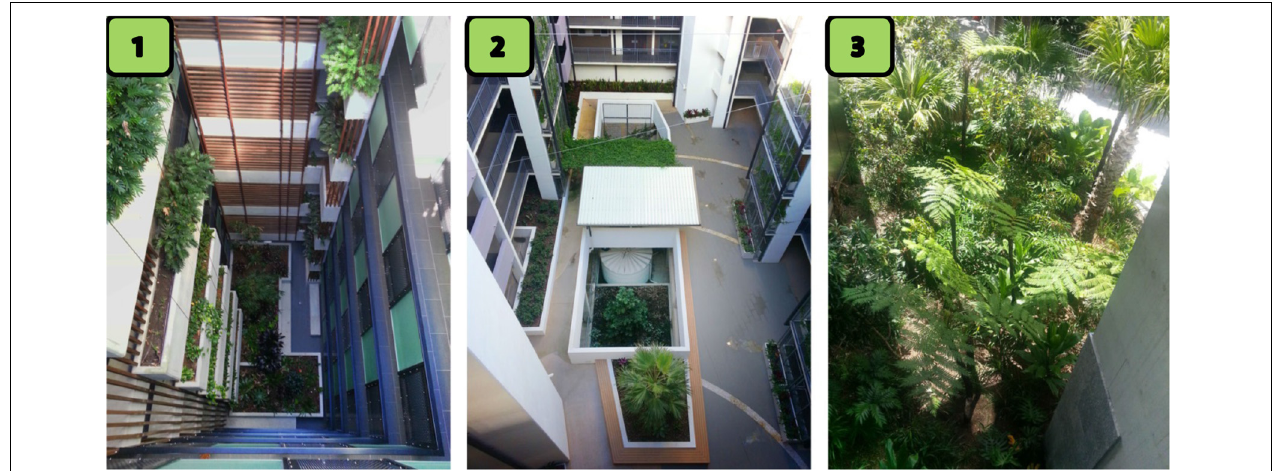
FIGURE 1 | Photographs of the three building sites, labeled as 1–3 used in this study to show that all plantings were outside the